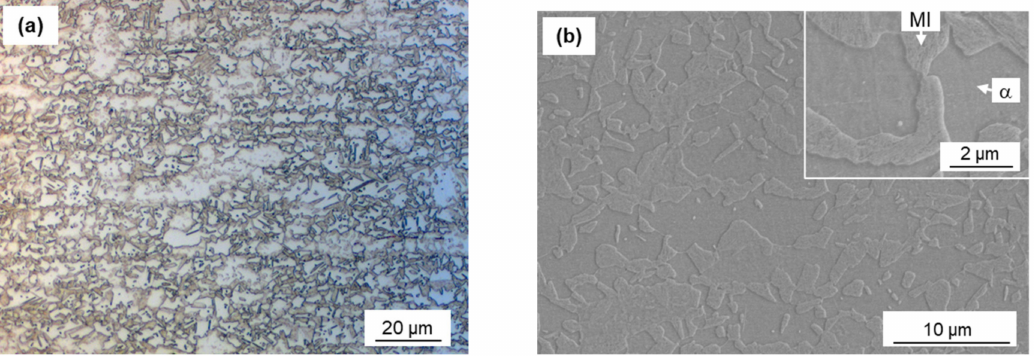
Figure 1. ( a ) Optical micrograph image of the base metal (BM) and ( b ) magnified SEM of the BM, showing mixture of ferrite ( α ) and martensite island